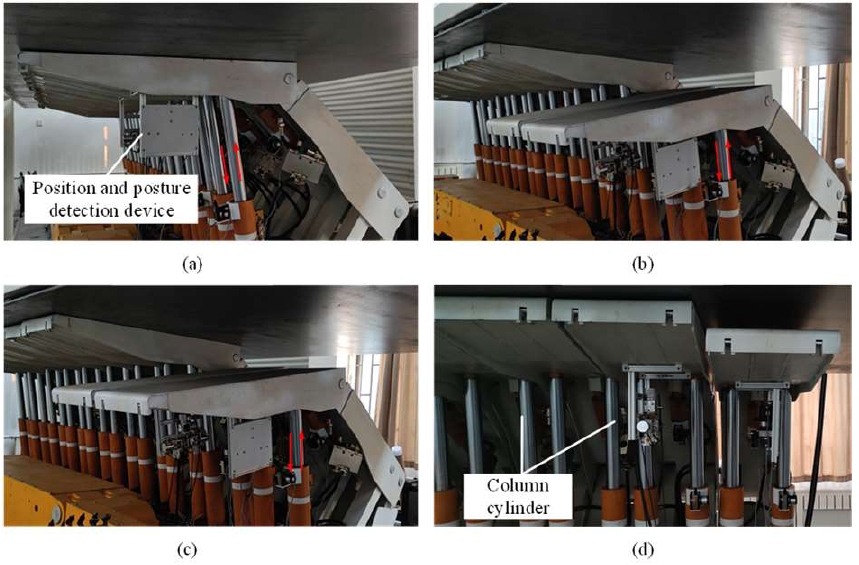
Figure 21. Following motion experiment of the column cylinder of hydraulic support. ( a – d ) shows the position of the column cylinder and the expansion trajectory.